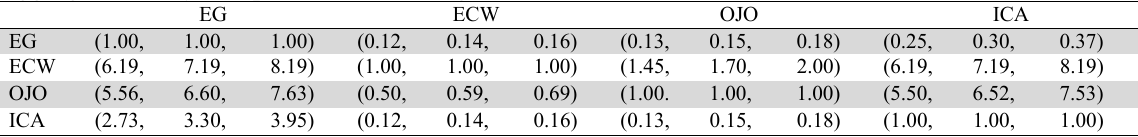
Aggregated fuzzy comparison matrix of